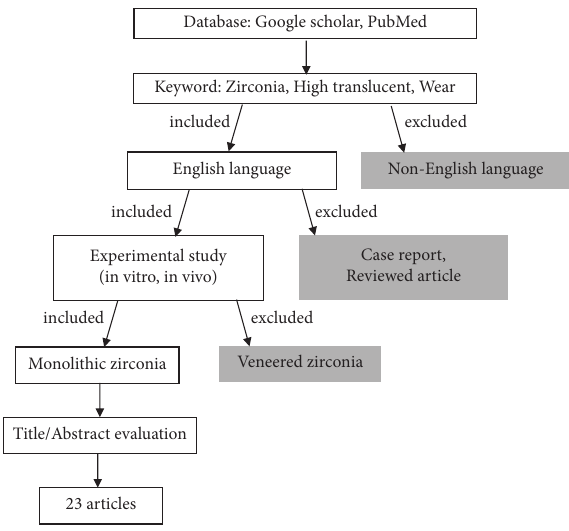
Figure 1: Article selection